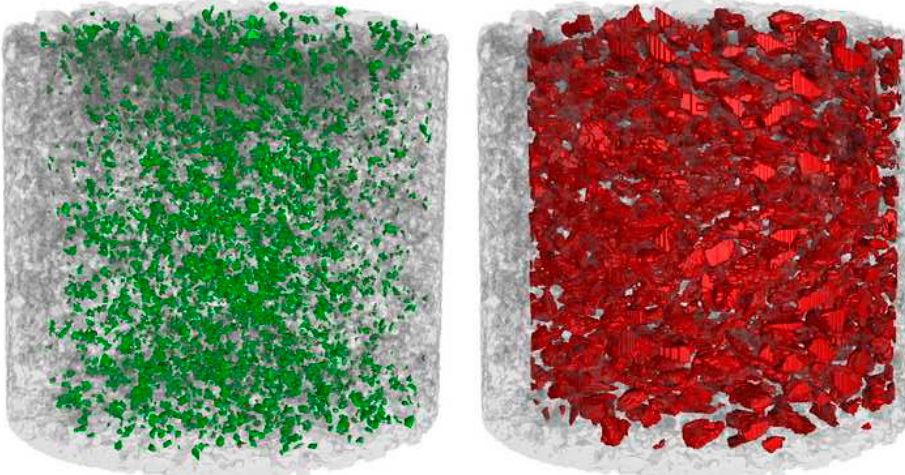
Figure 8. 3D images of the whole cylinder, as discussed in the text. The spatial distribution inside the sample of the large virgin and small RAP aggregates is shown with different colors (red and green, respectively).